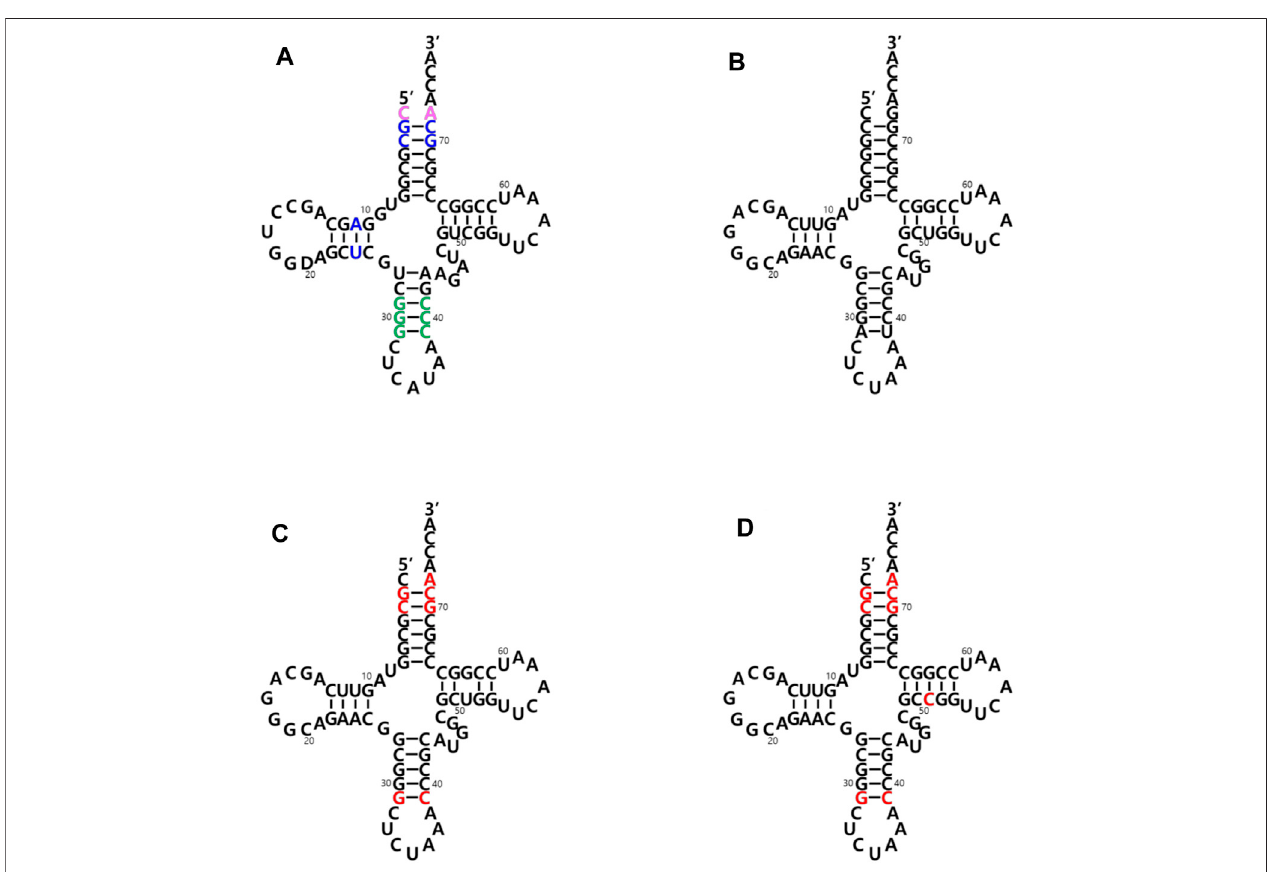
FIGURE2| CloverleafdepictionoftRNAsused inthisstudy. (A) E.coli initiator tRNA (Ec-tRNA fMet ).Thetwomainidentityelements of Ec -tRNA fMet aretheabsence of a Watson-Crick base pair between positions C1 and A72 in the acceptor stem (in pink) and three consecutive G:C base pairs in the anticodon stem (in green). Some additionalelementsplayingaroleintheformylationreactionareshowninblue. (B) Engineered M.jannaschii tyrosyl-tRNA CUA ( Mj -tRNA Tyr ). (C) Mj initiatortRNA CUA -1( Mj - itRNA-1). (D) Mj initiator tRNA CUA -2 ( Mj -itRNA-2). The changed nucleotides in Mj -itRNA-1 and Mj -itRNA-2 compared with Mj -tRNA Tyr are marked by red letters.